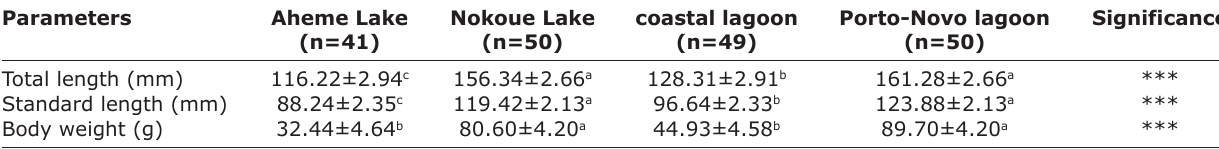
Table-1: Morphometric parameters of Tilapia guineensis in different streams.